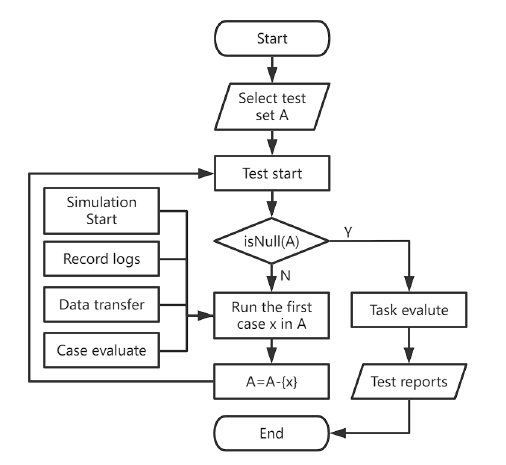
Figure 5. CarTest test flow